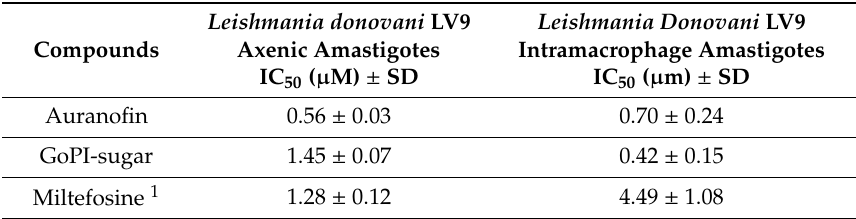
Table 8. In vitro activities of gold(I) complexes in L . donovani LV9 axenic amastigotes and intramacrophage amastigotes.